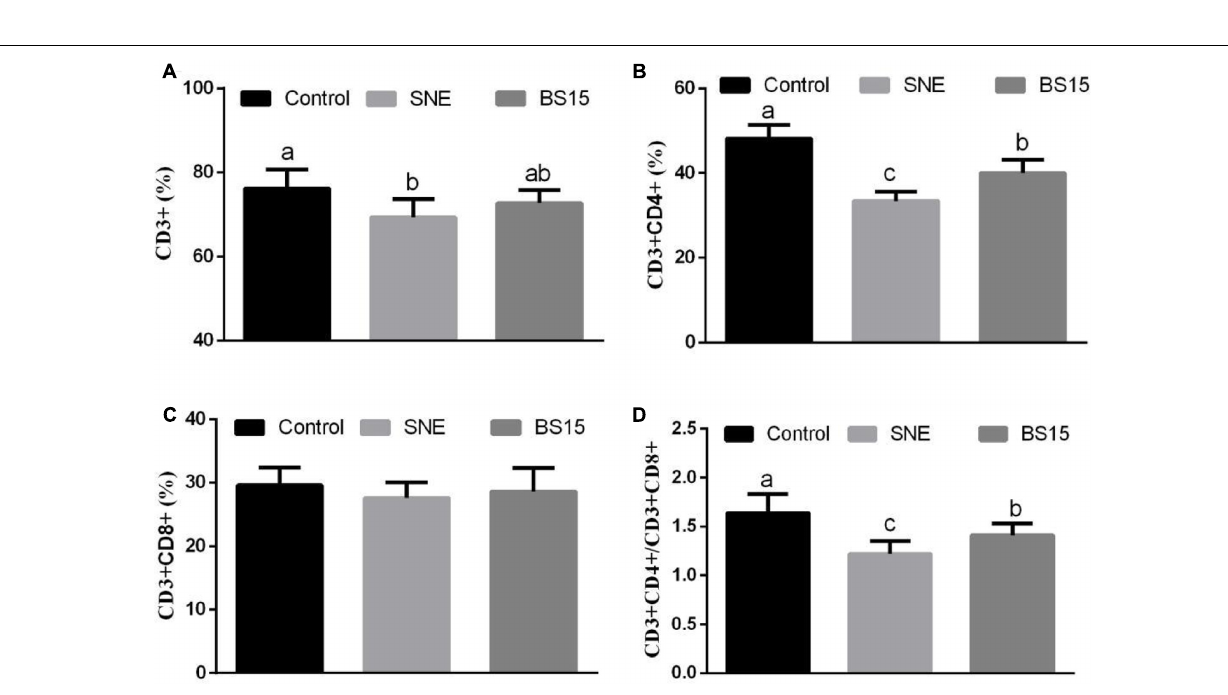
Frontiers in Microbiology |